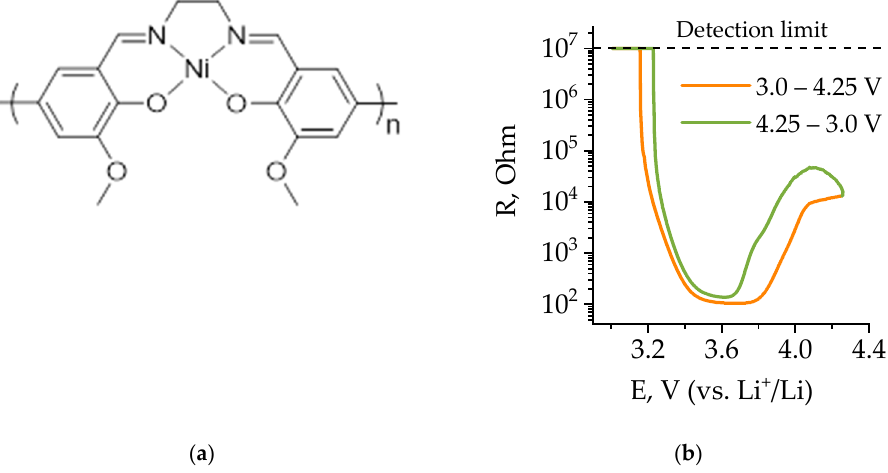
Figure 1. Poly[Ni(CH 3 OSalen)]structure ( a ) and resistance of the poly[Ni(CH 3 OSalen)] layer in 1 M LiPF 6 EC/DEC electrolyte, according to the data of [46] ( b ).